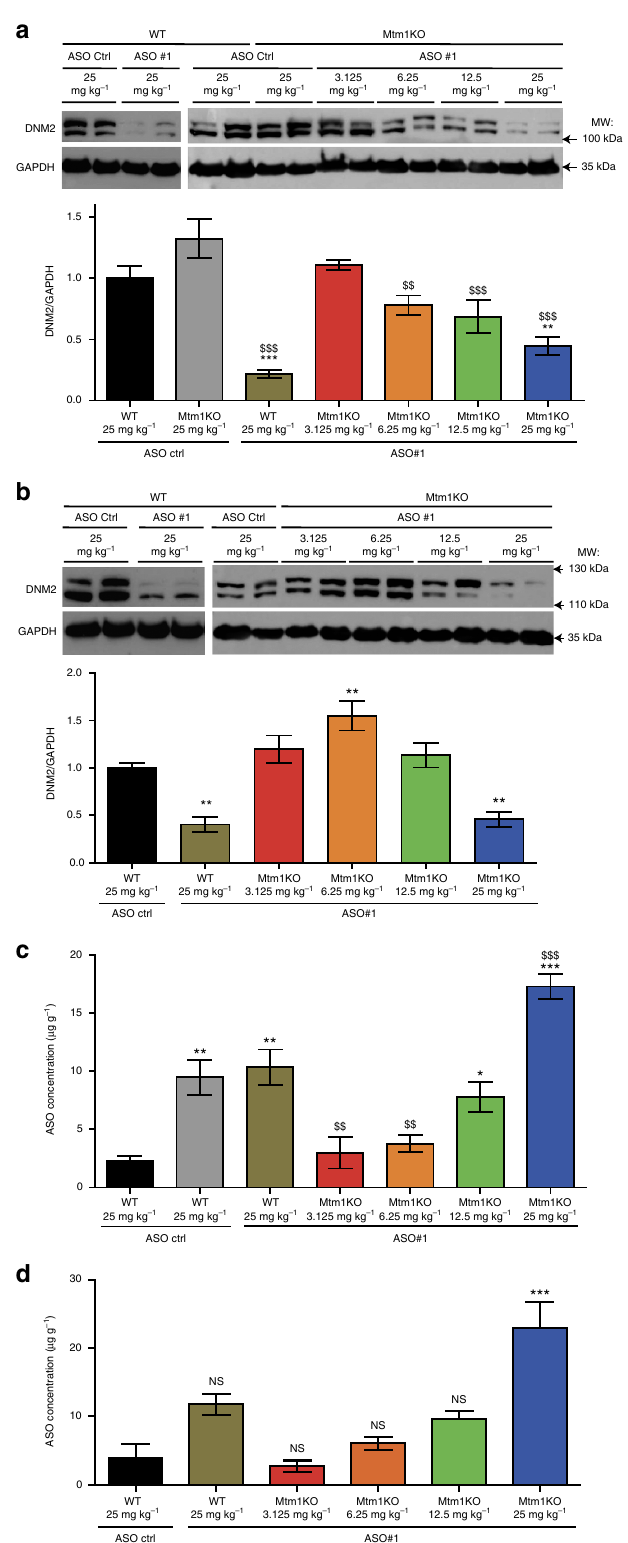
Figure 7 | DNM2 knockdown and ASO concentration in skeletal muscles. ( a , b ) DNM2 and GAPDH (loading control) expression in TA muscles